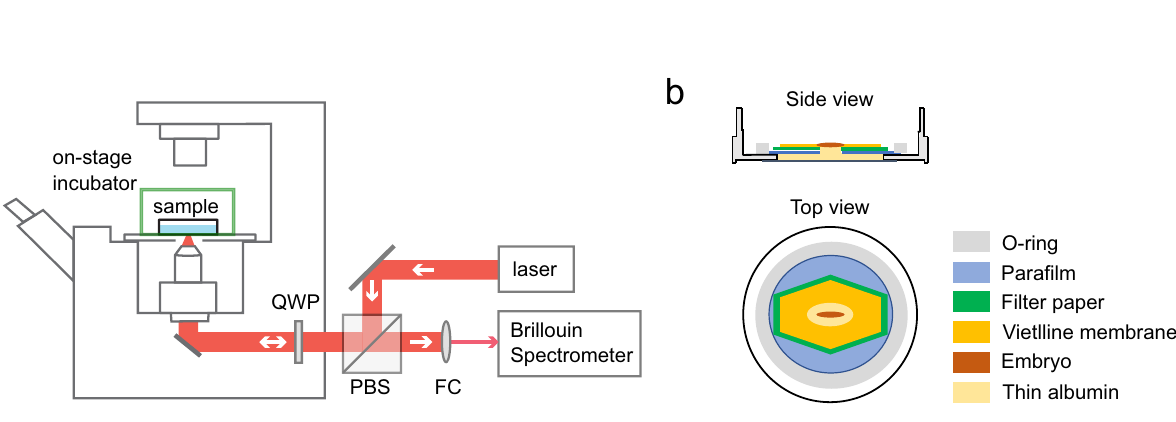
Figure 1. Schematic of the setup. ( a ) Confocal Brillouin microscope with on-stage incubator. QWP quarter- wave plate, PBS polarized beam splitter, FC fiber coupler. ( b ) Carrier dish for ex ovo culture. Side view (top) and top view (bottom) displays all components including embryo within the